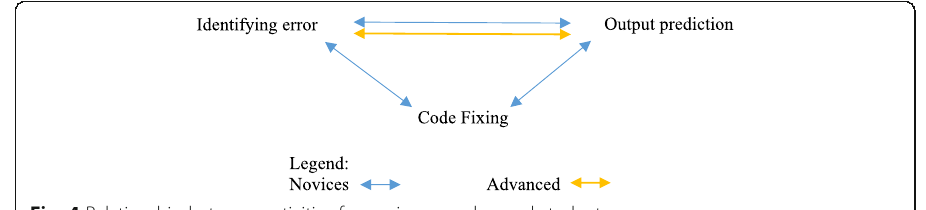
Fig. 4 Relationship between activities for novices vs. advanced students